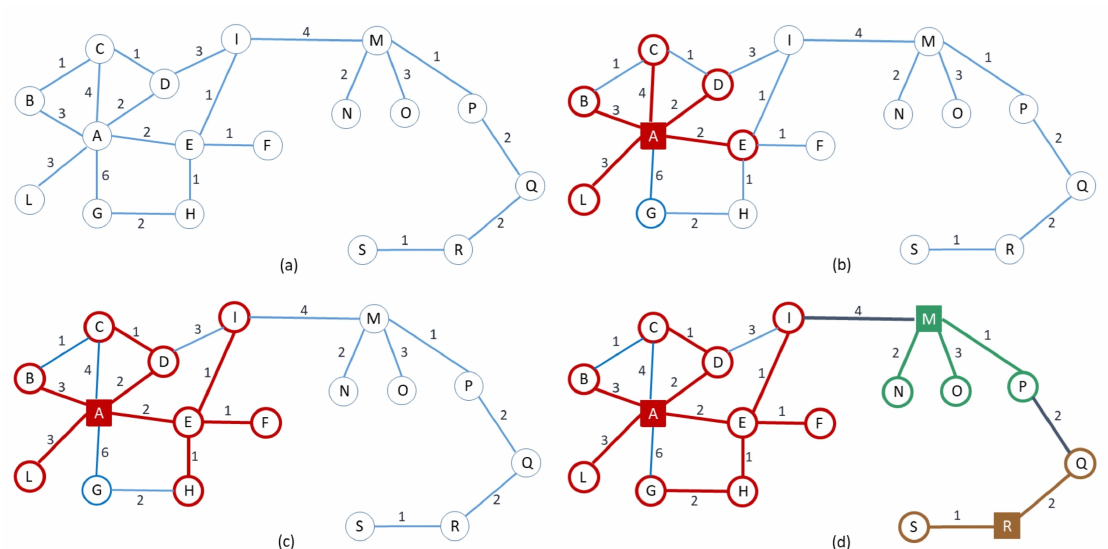
Figure 2. A specific execution of R AND C LUSTER on the weighted graph depicted in ( a ), with r = 2. In Iteration i = 1 of the for loop, only node A is (randomly) selected, and the two growing steps ( b ), ( c ) are performed. The resulting partial cluster centered at A is highlighted in red. In Iteration 2, two further centers, M and R , are selected, and only one growing step ( d ) is executed. The resulting final clusters are highlighted in red, green, and